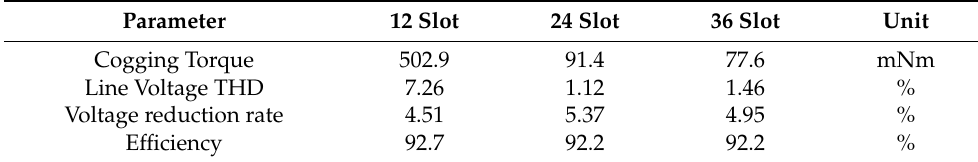
Table 3. Performance comparison according to the number of stator slots.